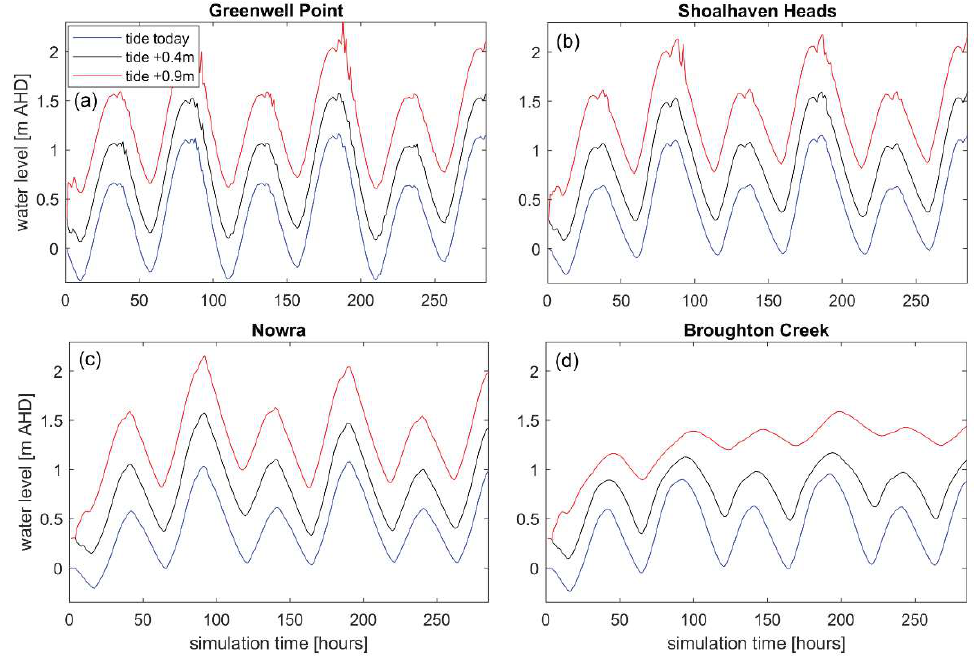
Figure 5. Simulated water levels for spring-tidal conditions and SLR scenarios over 6 tidal cycles at Greenwell Point ( a ), Shoalhaven Heads ( b ), Nowra ( c ), and Broughton Creek ( d ) in the Shoalhaven Estuary.